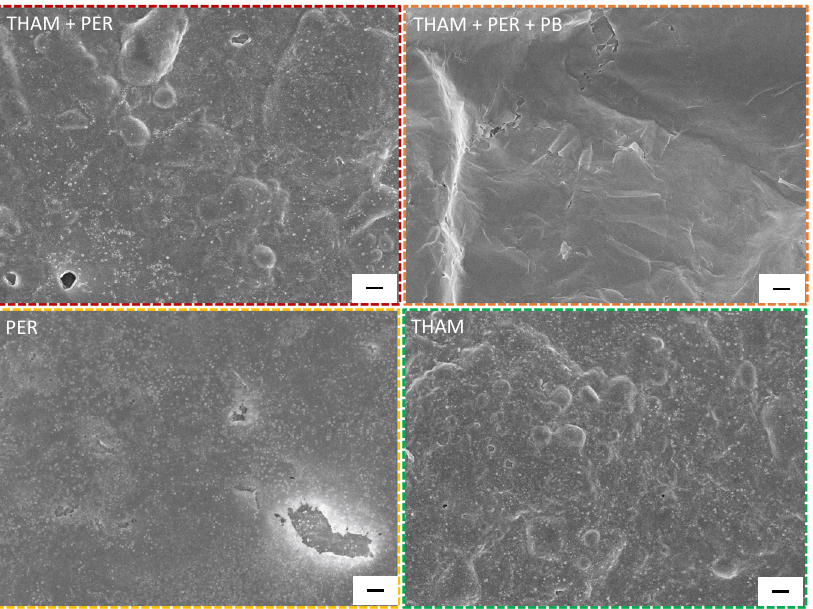
Fig. 7 SEM imaging. SEM images of 14 BL fi lms with varying additives: THAM + PER (red), THAM + PER + PB (orange), PER (yellow), and THAM (green). Nanoporosity and microscale layering and bubbling, which contribute to the overall fi lm thermal resistivity, can be observed. Scale bars are each 1 µm.